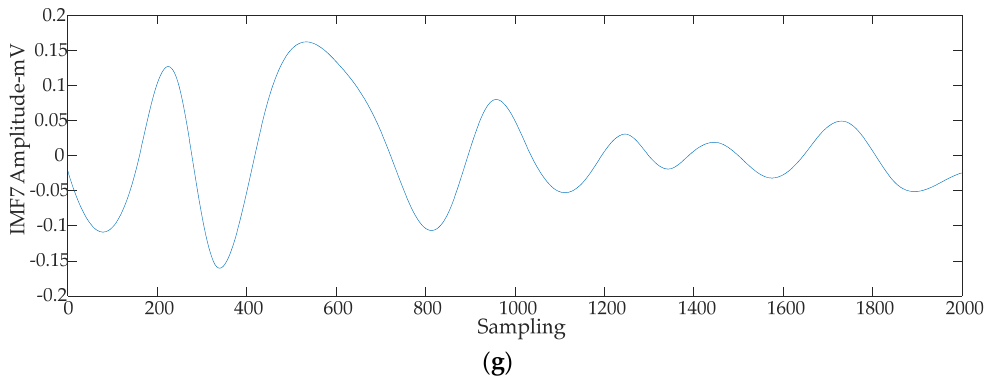
Figure 11. EMD for PD superimposed white noise interference signal. ( a ) IMF 1 -component. ( b ) IMF 2 -component. ( c ) IMF 3 - component. ( d ) IMF 4 -component. ( e ) IMF 5 -component. ( f ) IMF 6 -component. ( g ) IMF 7 -component.